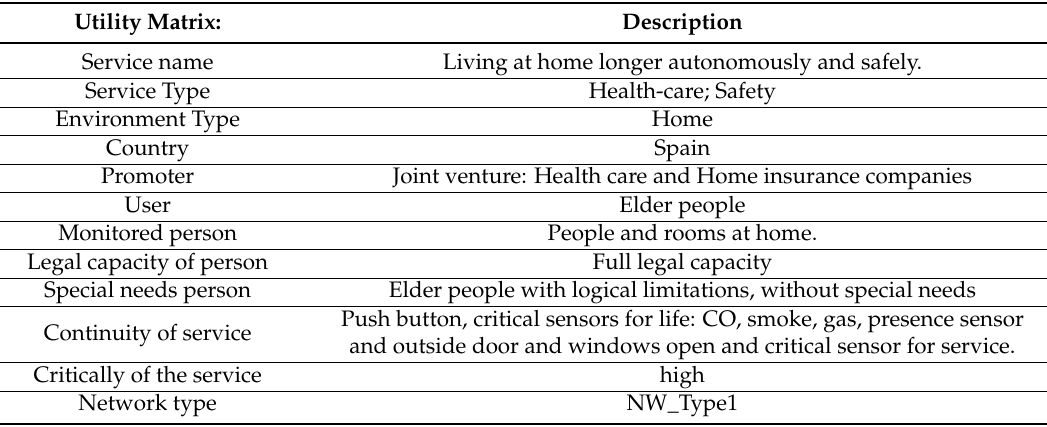
Table 3. Utility Matrix: Service.